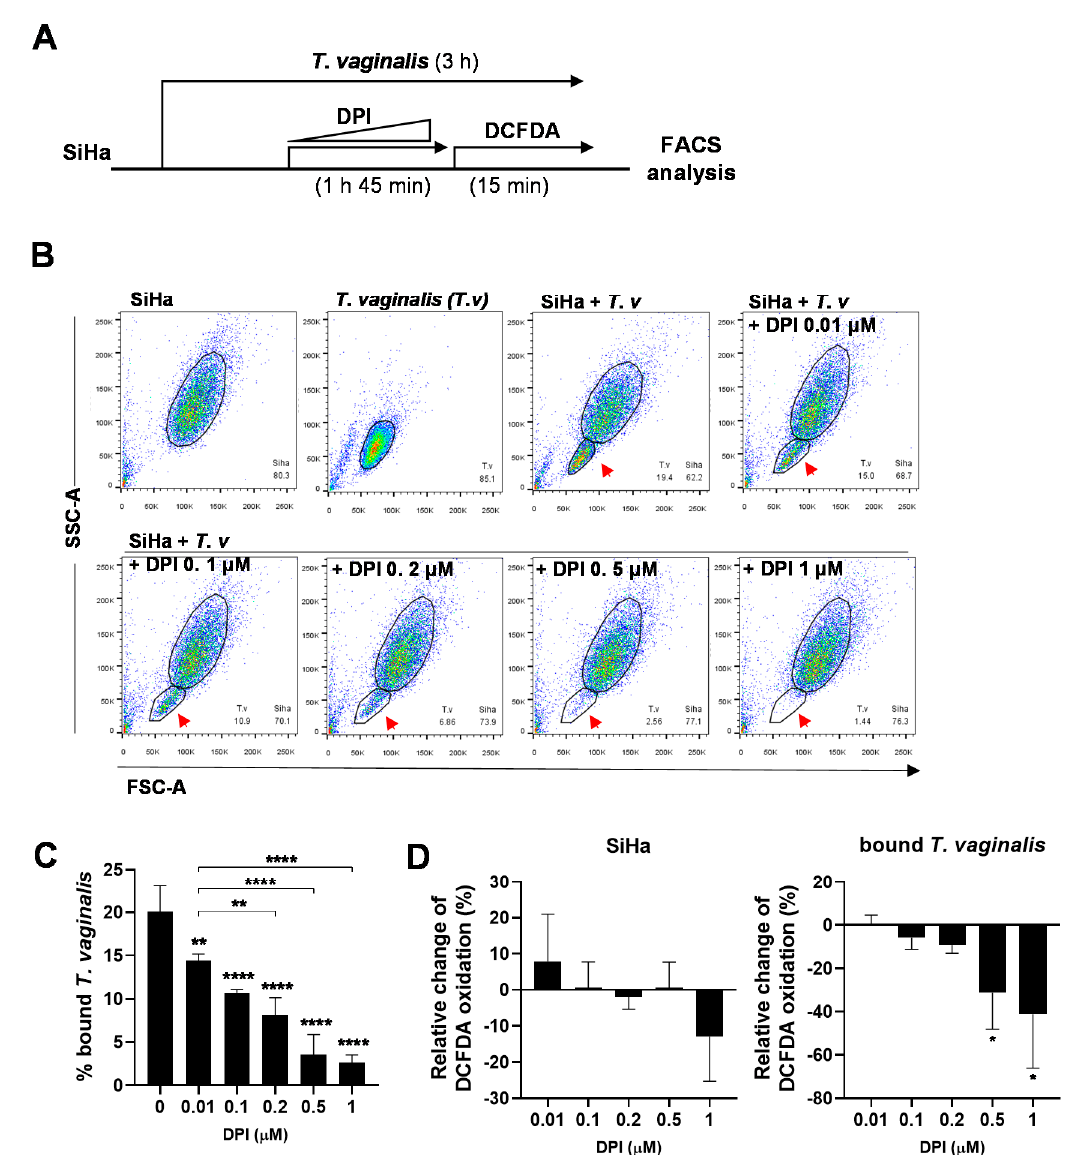
Figure 4. DPI induces detachment of T. vaginalis from SiHa cells in a dose-dependent manner and reduces ROS generation. ( A ) Experimental scheme: SiHa cells were infected with T. vaginalis for three hours, with DPI treatment at the indicated concentrations for the last 2 h prior to incubating with 1 µ M CM-H 2 DCFDA for the last 15 min. Attached cells were analyzed by flow cytometry. ( B ) Representative FSC-A / SSC-A dot plot of the attached cell populations. Attached T. vaginalis cells are indicated by red arrows. ( C ) Bound T. vaginalis levels were quantified from flow cytometry data ( n ≥ 3). ( D ) Levels of CM-H 2 DCFDA oxidation in SiHa cells and bound T. vaginalis relative to DPI untreated samples. Mean ± SD, one-way ANOVA. * p < 0.05, ** p < 0.01, **** p < 0.0001. The data represent triplicate experiments.